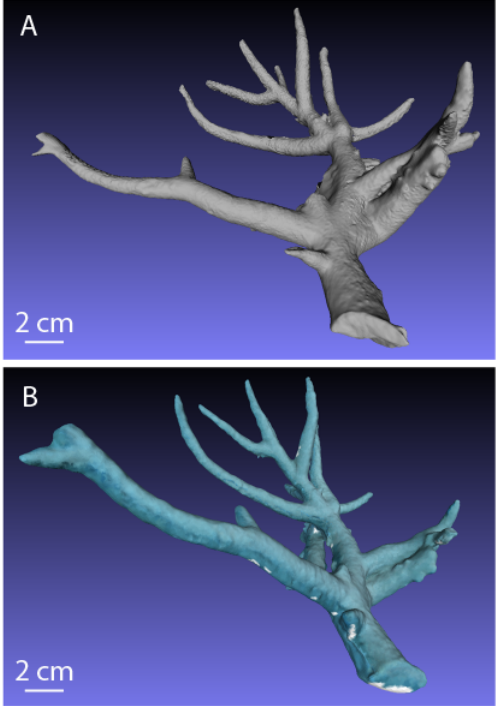
Figure 3. ( A ) Laser-scan reference model of the branching coral acquired with a Cyberware laser-stripe scanner; and ( B ) final 3D reconstruction of the